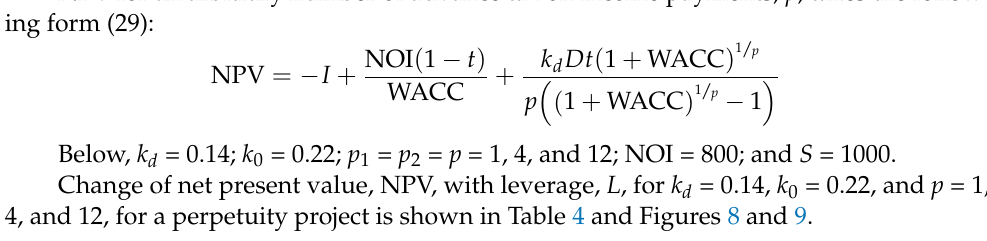
Figure 7. Change of net present value, NPV, with leverage, L , for k d = 0.14, k 0 = 0.22, and p = 1, 4, and 12, for a perpetuity project (larger scale). Table 3. Change of net present value, NPV, with leverage, L , for k d = 0.14, k 0 = 0.22, and p = 1, 4, and 12.